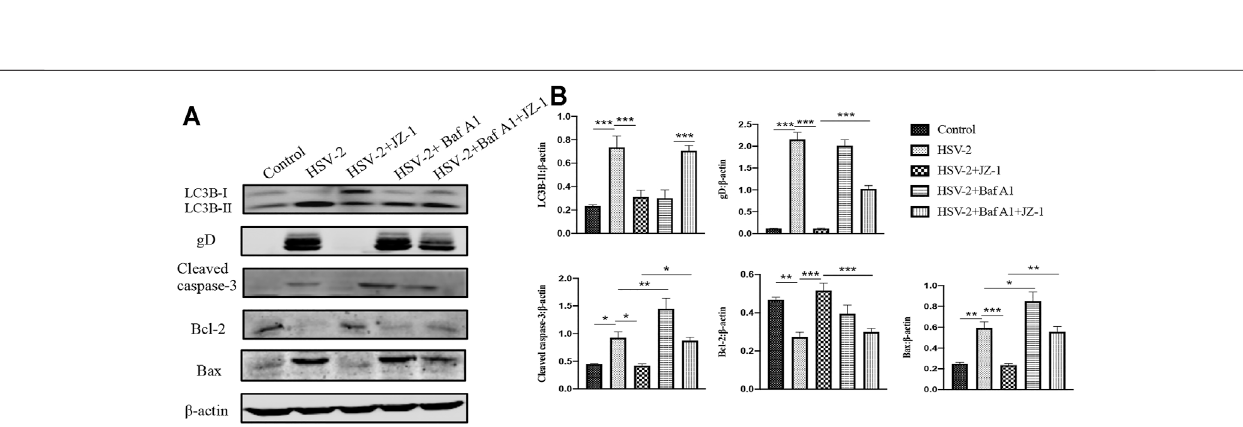
FIGURE8| JZ-1canexertitsanti-apoptoticeffectbyinducingautophagyinVK2/E6E7cells. (A) RepresentativewesternblotsforLC3B-II,gD,cleavedcaspase-3, andBaxinVK2/E6E7cellsofdifferentgroups. (B) Thequanti fi cationofLC3B-II,gD,cleavedcaspase-3,andBaxwesternblots.Alldataarepresented asmeans ± SEM.